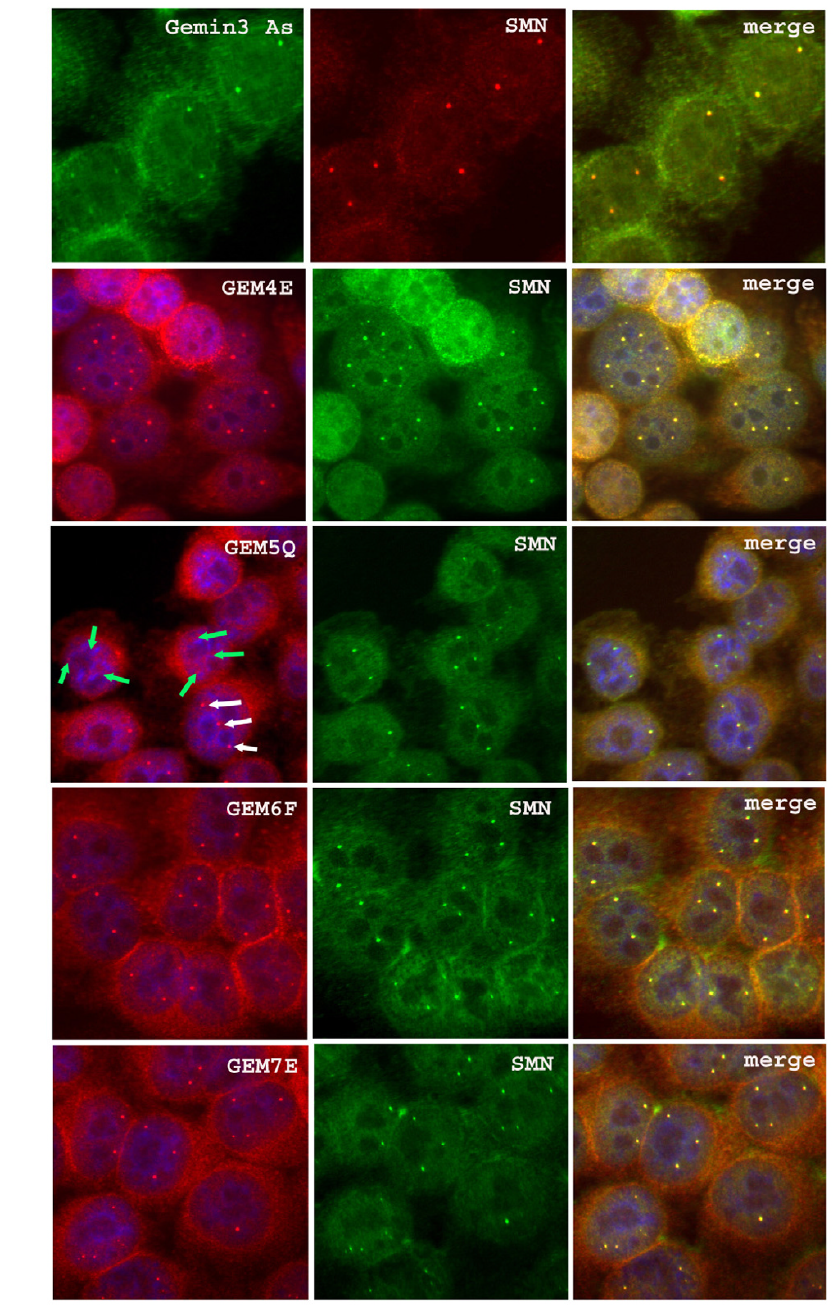
Figure 2 Gemins 3, 4, 6 and 7 colocalise with SMN in nuclear gems/CBs, but gems/CBs in most cells lack gemin5 . HeLa cells grown on coverslips were fixed with 1% formalin in PBS and permeabilized with 1% Triton X-100. Gemins 4, 5, 6 and 7 were identified using GEM4E, GEM5Q, GEM6F and GEM7E, respectively in a double label with SMN rabbit antiserum. Typical fields are shown, except that an unusual field containing several cells with gemin5-positive gems/CBs was chosen for GEM5Q. The anti-gemin3 rabbit antiserum was double-labelled with MANSMA1 mAb against SMN. Alexa fluor 546 goat anti-mouse IgG (red) and Alexa fluor 488 goat anti-rabbit IgG (green) were used as second antibodies. DAPI (blue) was used to counterstain the nuclei. (See text for white and green